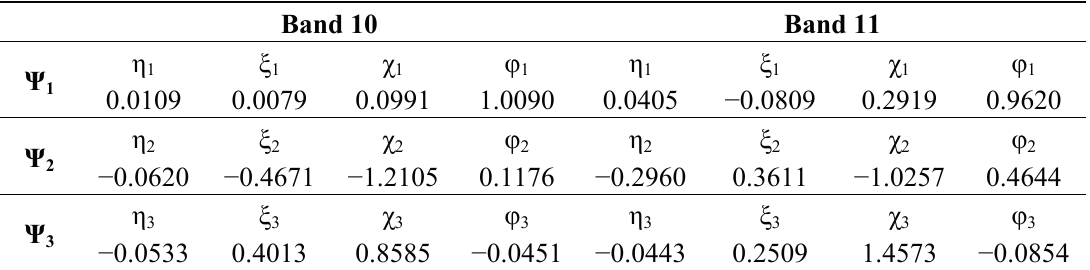
Table 3. Parameters for estimation Ψ SC